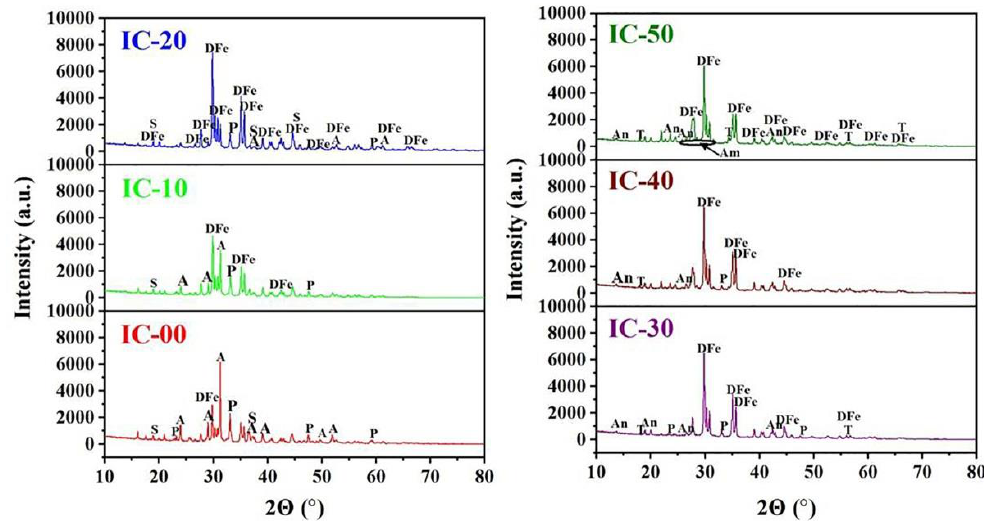
Figure 3. XRD patterns of the ceramic samples. A = Akermanite, DFe = Fe-bearing diopside, P = Perovskite, S = Spinel, An = Anorthite, T = Titanite, Am = Amorphous.